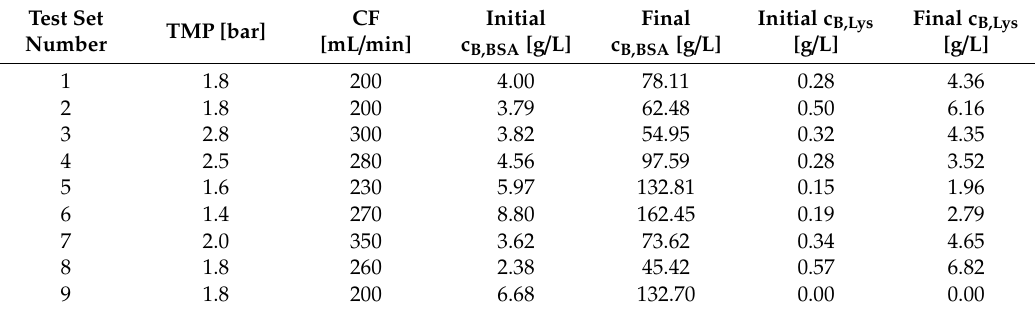
Table A2 summarized the parameters chosen for the test experiments: TMP, CF, initial c B, and measured final c B of BSA and lysozyme. Table A2. Summary of the test sets with varying initial c B s, CF, and